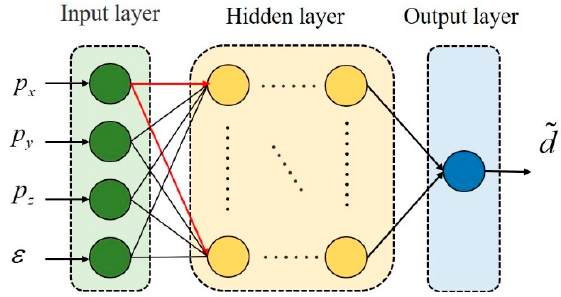
Figure 5. Structure diagram of the HNN.